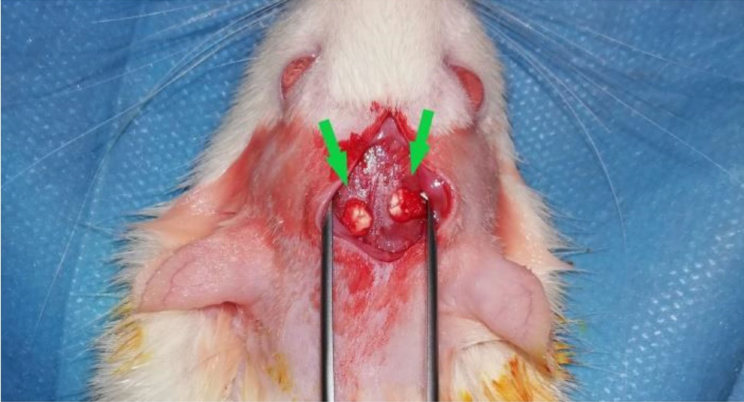
Figure 11. Representative picture of the implantation procedure. Two calvarian defects were implanted with jellyfish collagen sca ff olds (green